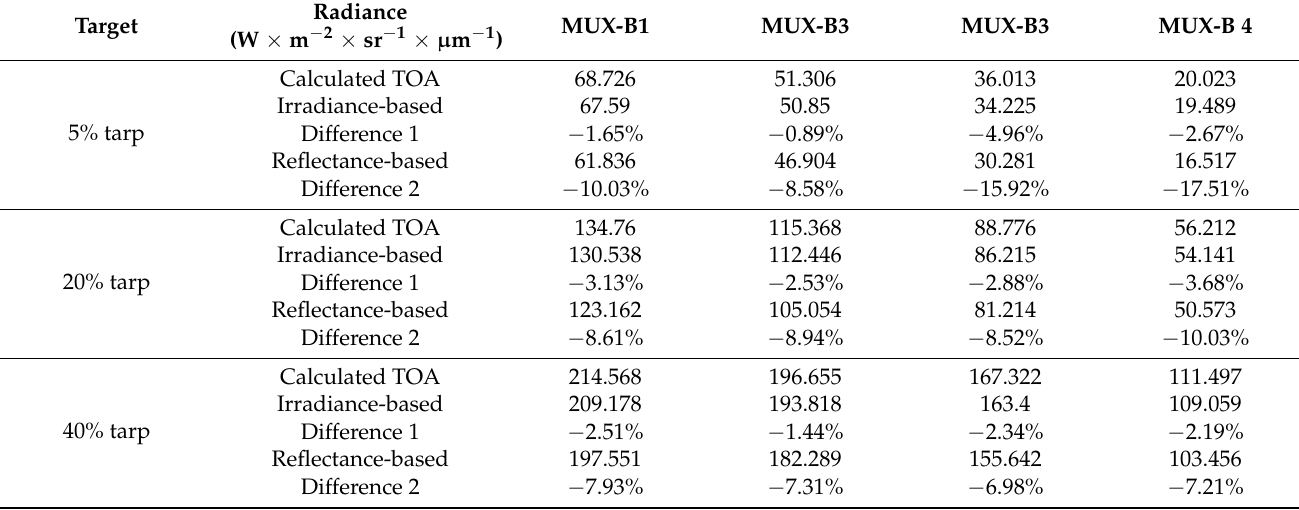
Table 9. Difference between the TOA radiance predicted by calibration methods and the calculated TOA radiance using official calibration coefficient (28 June